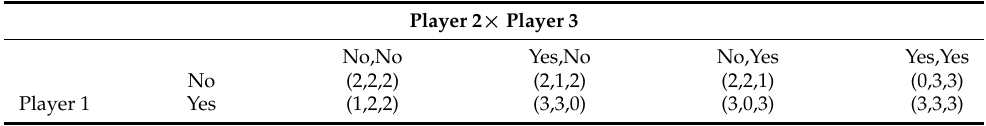
Table 7. The 3-person-induced non-cooperative game